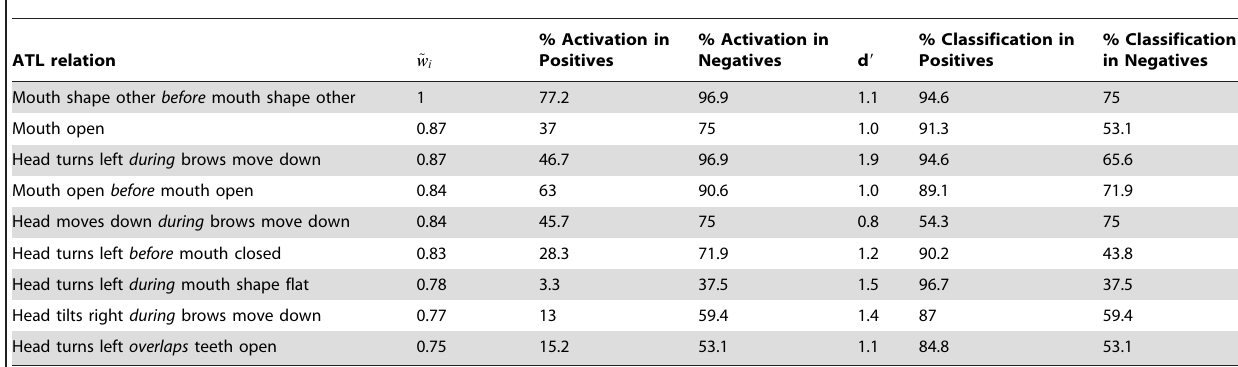
Table 10. Discriminant features for polarity in Wh-questions postposed.